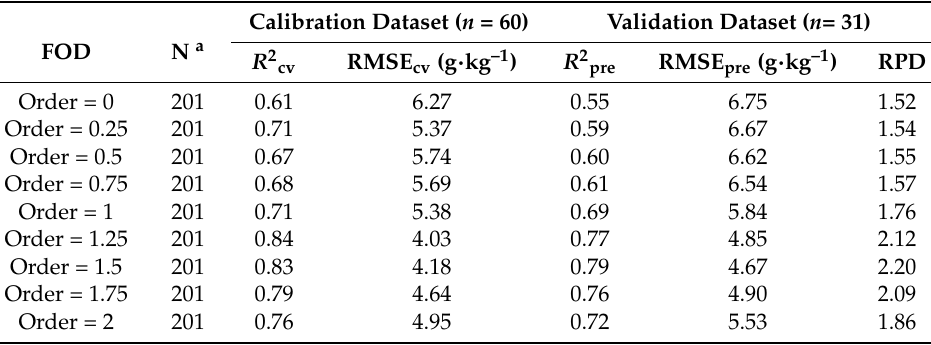
Table 1. Modeling results of full-spectrum support vector machine (SVM) models for SOM with different FOD preprocessing